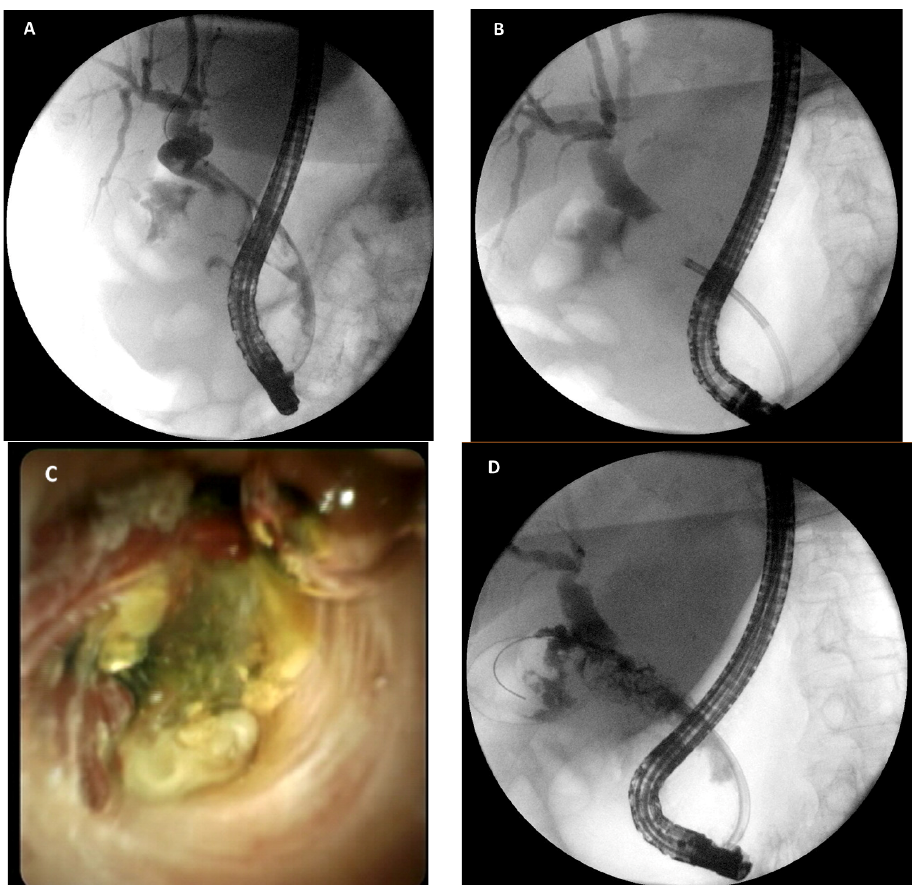
Figure 4. ( A ) cholangiogram showing a large stone impacted at the cystic duct insertion, obstructing the common bile duct; ( B ) fluoroscopic image of the cholangioscope approaching the impacted stone; ( C ) direct visualization of the impacted stone and inflamed biliary mucosa during cholangioscopy; ( D ) fluoroscopic image of the fragmented stone after electrohydraulic lithotripsy.